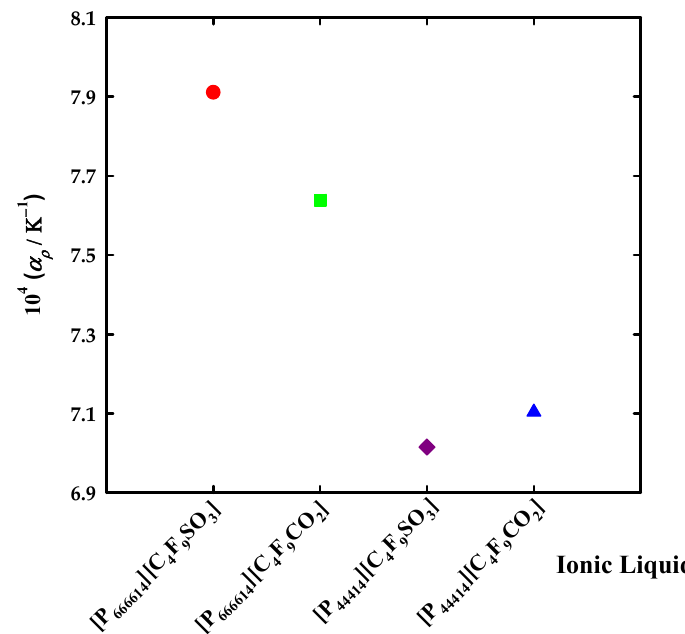
Figure 2. Isobaric thermal expansion coefficients ( α p ) for the synthesized fluorinated ionic liquids.